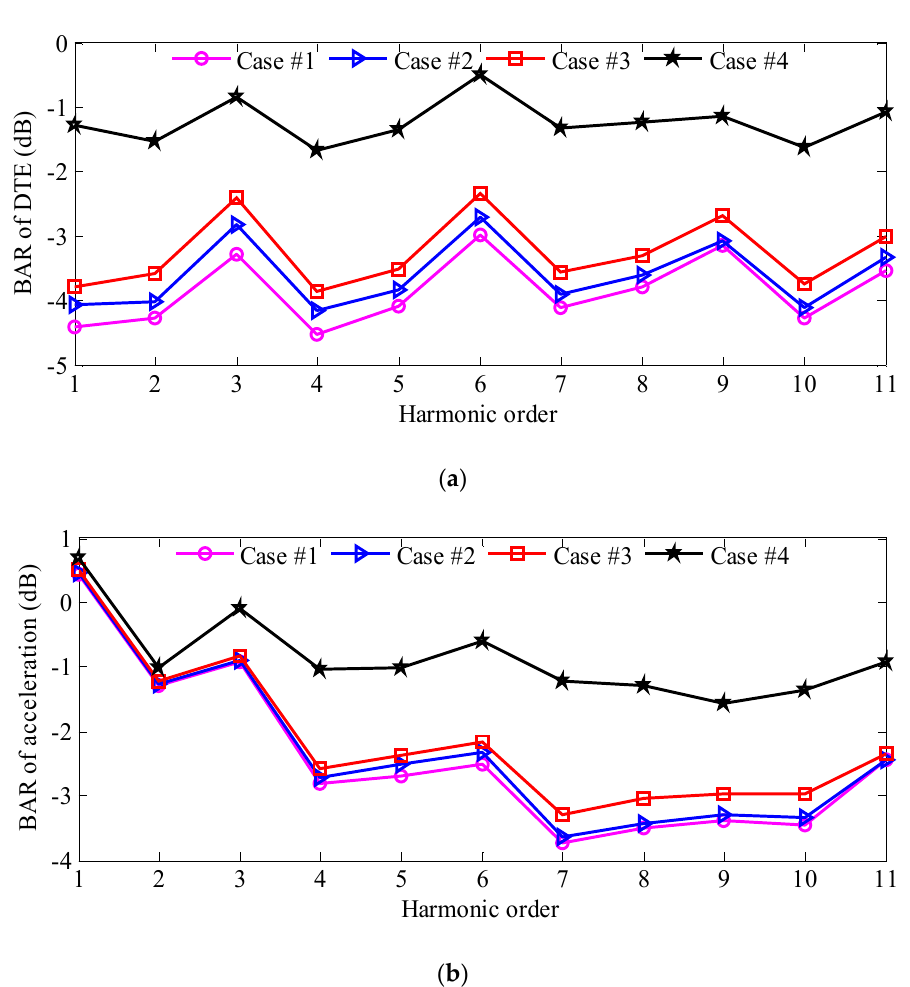
Figure 16. BAR of different fault cases: ( a ) DTE, ( b ) acceleration.